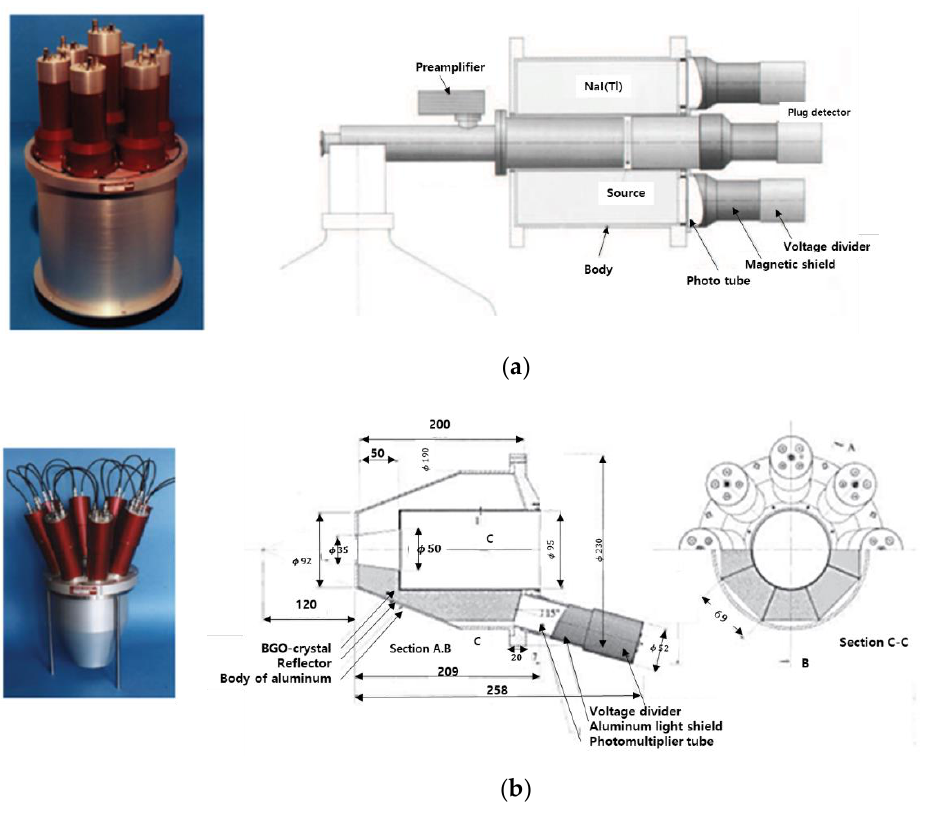
Figure 9. Compton suppression system using HPGe and a guard detector. ( a ) NaI(Tl) is used as a guard detector ( b ) BGO is used as a guard detector [37].